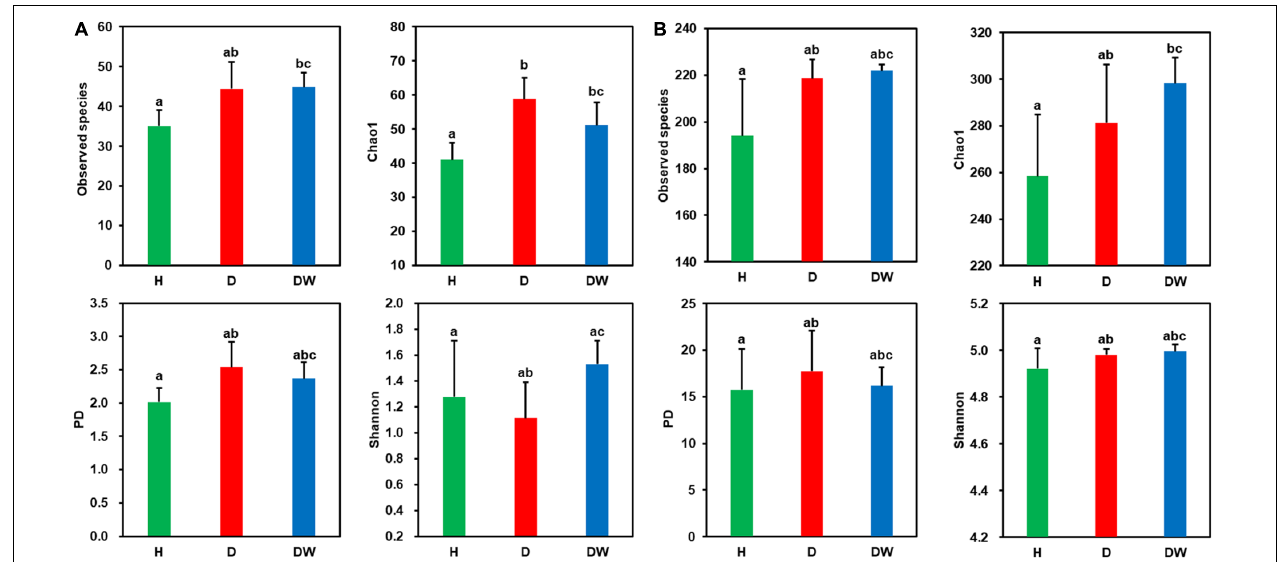
FIGURE 2 | Comparisons of diversity indices for Pyropia yezoensis -associated (A) and seawater-borne (B) bacterial communities between different health statuses. Error bars indicate standard deviations, and the letters on the error bars indicate significant differences ( P < 0.05) based on unpaired wilcoxon rank sum tests.